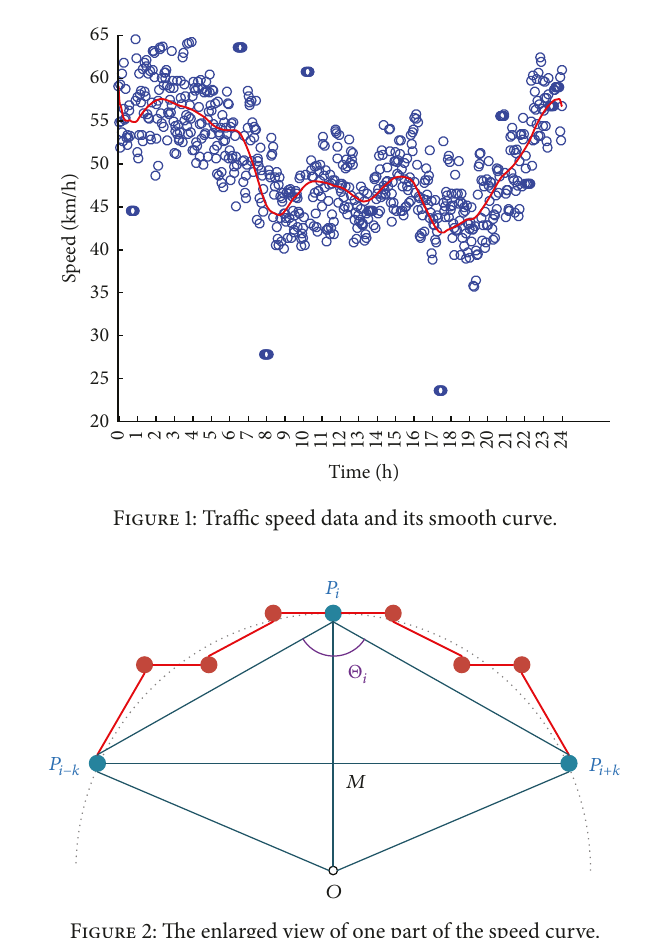
Figure 2: The enlarged view of one part of the speed